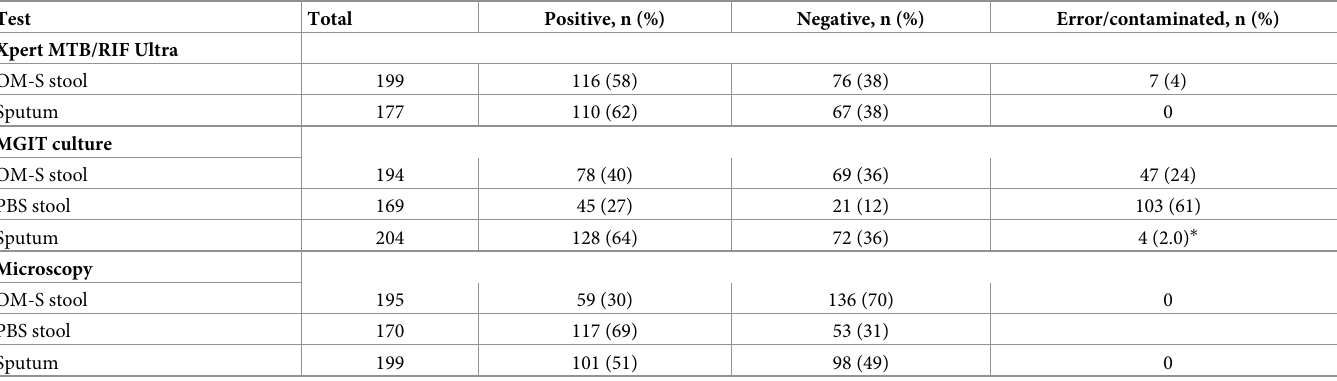
Table 2. Results of stool and sputum samples per